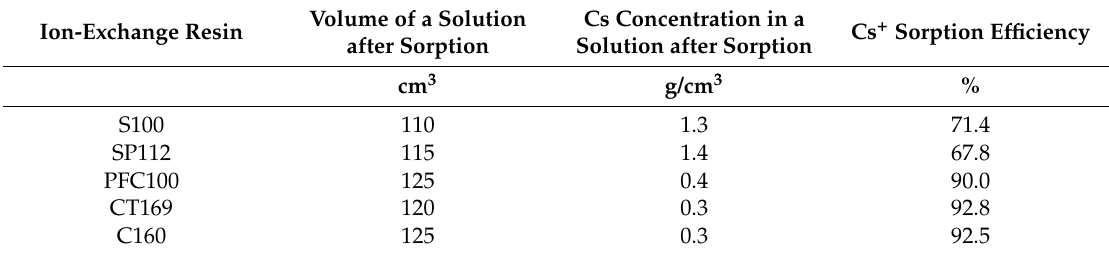
Table 1. Results of ion-exchange resin selection for cesium